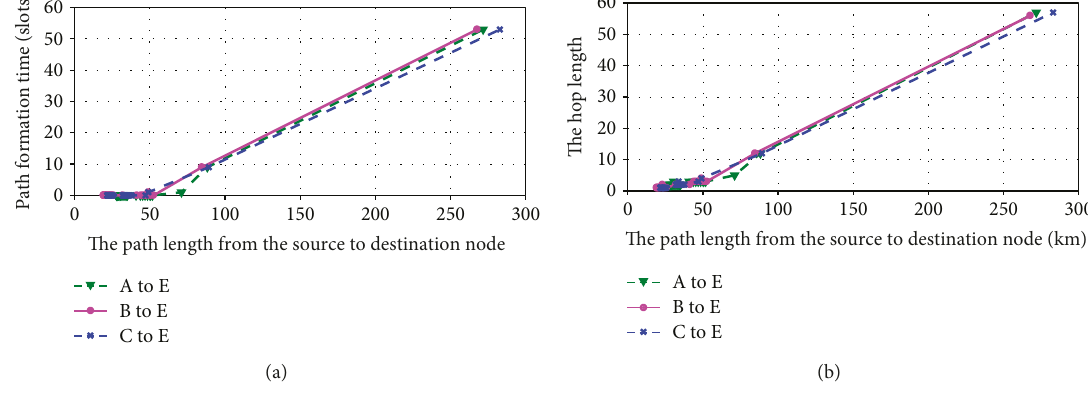
Figure 11: (a) The relationship between path formation time and path length. (b) The relationship between hop length and path length for di ff erent source-destination in the 12th orbit